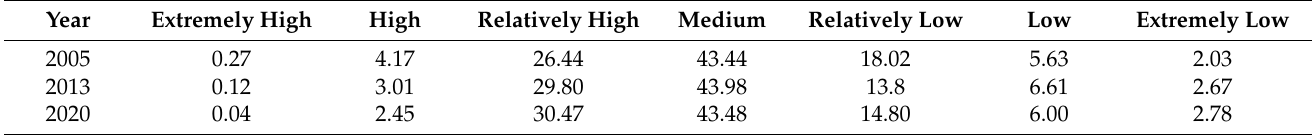
Table 4. Proportion of different temperature grades (%) in 2005, 2013, and 2020. Year Extremely High High Relatively High Medium